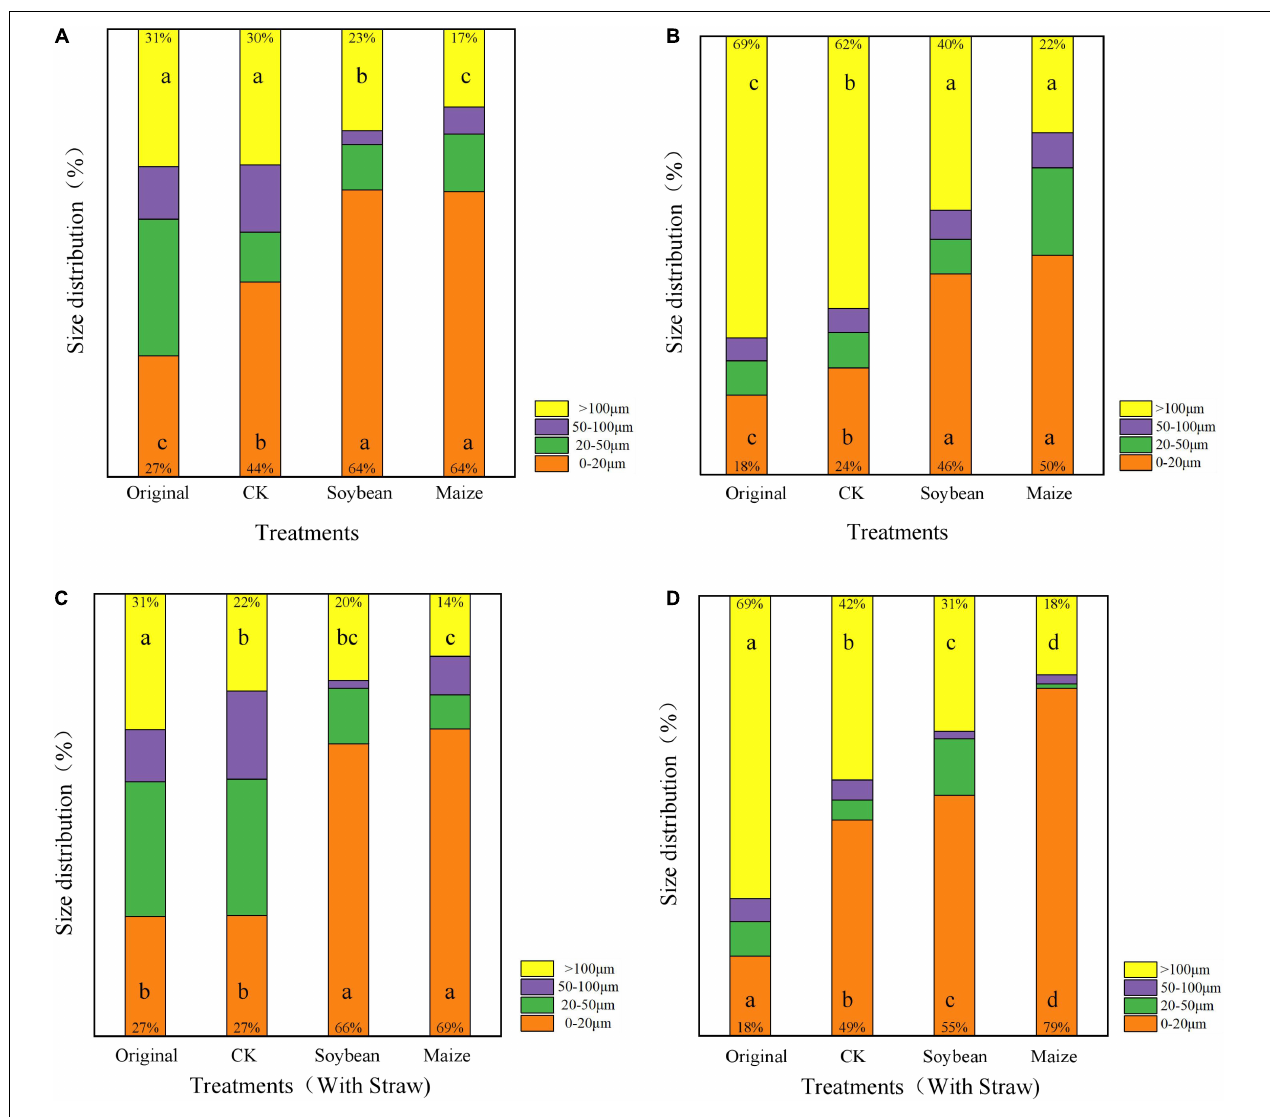
FIGURE 4 | The abundance proportion of single-particle size to the total particle size of low-density polyethylene (LDPE) and low-density polypropylene (LDPP) microplastics in the treatments of crop growth (soybean and maize, with and without straw addition). (A) LDPE-MP, (B) LDPP-MP, (C) LDPE-MP (with straw), and (D) LDPP-MP (with straw). CK was the control treatment without crop growth, and the original was LDPE-MPs and LDPP-MPs without any treatment. Columns followed by the same letter at the same particle size were not significantly different based on a least significant difference (LSD) multiple range test ( p <